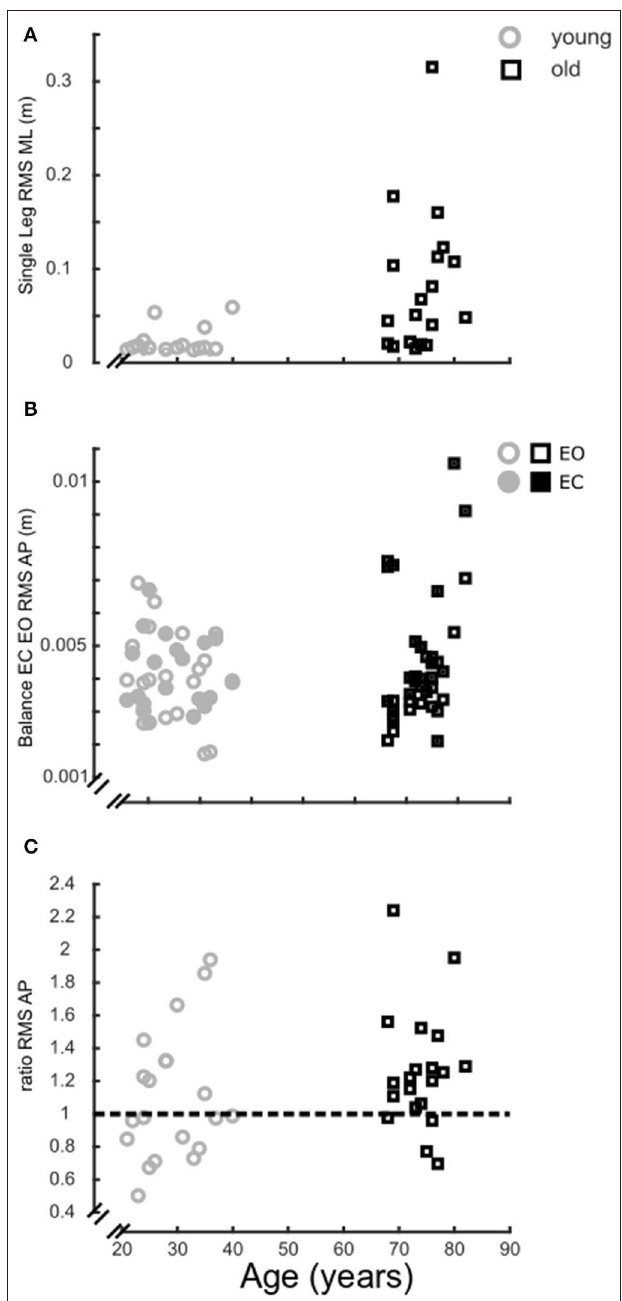
FIGURE 11 | Balance ability. Balance performance over age, grouped in older (black) and younger participants (gray). (A) , Medio-lateral root mean square (RMS) of the CoP trace of the single leg balance trial (5s); (B) , Antero-posterior RMS of the CoP trace for the quiet standing trials (30s) with eyes closed (filled) and eyes open (open); (C) , Ratio of the antero-posterior RMS CoP for the quiet standing trials with eyes closed over eyes open